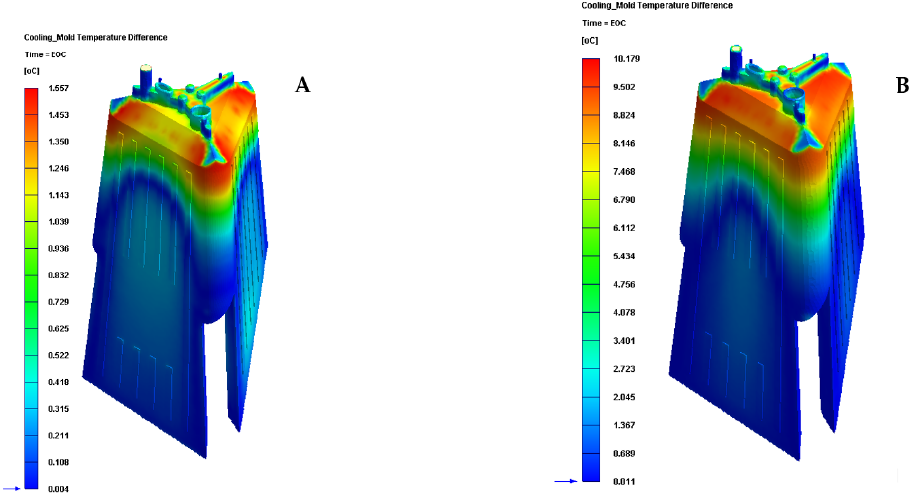
Figure 15. Cooling mold temperature difference (°C). ( A ) New conformal cooling system and Fastcool insert. ( B ) Traditional cooling. Table 9. Cooling mold temperature difference for the analyzed cooling systems.